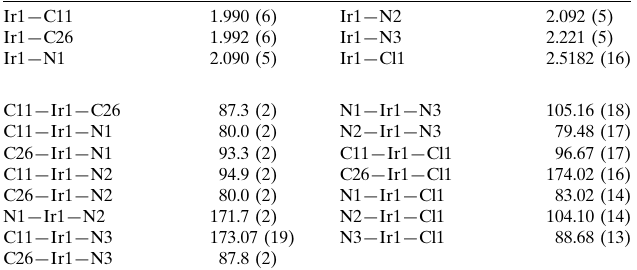
Selected geometric parameters (A˚ , (cid:2)